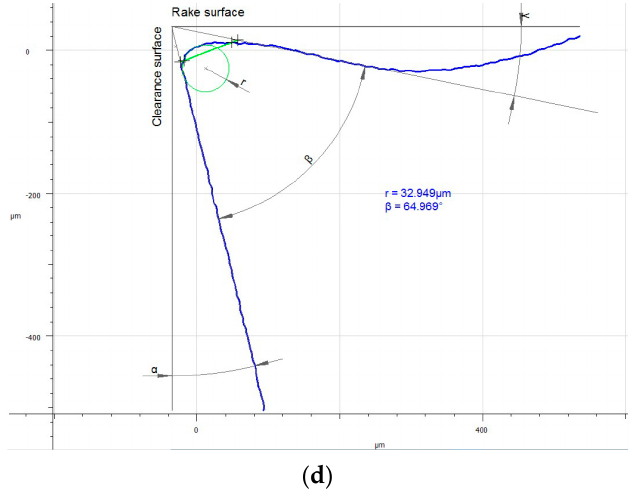
Figure 11. Comparison of the micro geometry of the cutting edges based on the radius of the cutting edge rounding, r n : ( a ) cutting insert with 1105 coating; ( b ) cutting insert with 1115 coating; ( c ) cutting insert with S05F coating; ( d ) cutting insert with S205 coating.